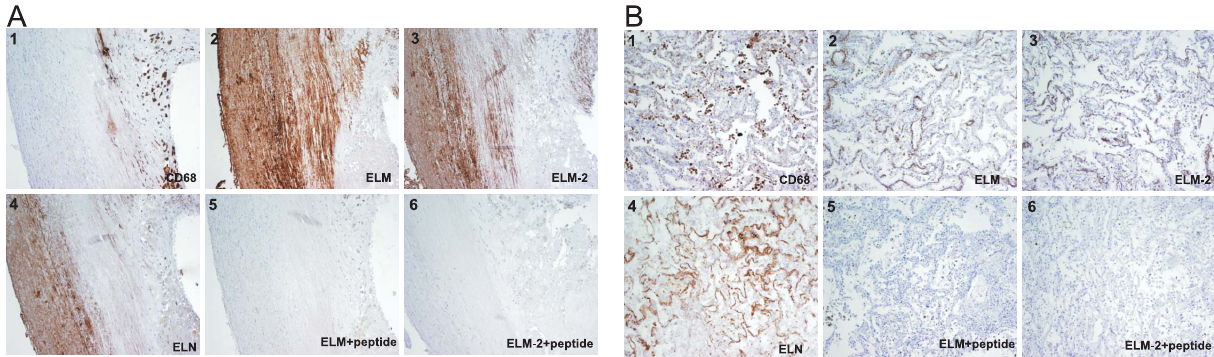
Figure 2. Tissue distribution of CD68, elastin (ELN), ELM and ELM-2. ELM and ELM-2 monoclonal antibodies were also mixed with the related free peptide as a control. A) Cross section of the plaque shoulder of a carotid artery from a 77 old man B) Left lung from a patient diagnosed with IPF. All pictures were taken with 10 6 magnification.